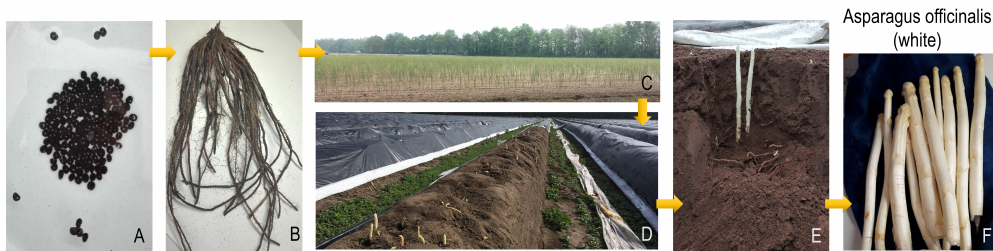
Figure 2. Asparagus officinalis (white) from seed to harvested product. ( A ) asparagus seeds, primed in water in order to help germination when sown. ( B ) asparagus root crown, one-year old, ready to be planted in the field. ( C ) new asparagus field with two-year old plants. ( D ) asparagus field in harvesting season with plastic covers to raise soil temperature. The black plastic covers the plants during the whole harvesting period to eliminate light exposure to the spears. ( E ) white asparagus shoots emerging from 40 cm deep in the soil. ( F ) harvested white asparagus spears. All pictures taken in Limburg, The Netherlands (spring